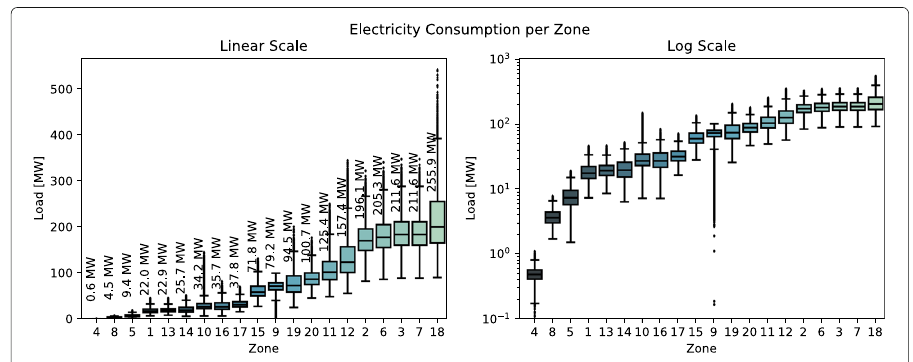
Fig. 2 Statistics of the 20 zones of the GEFCom 2012 data